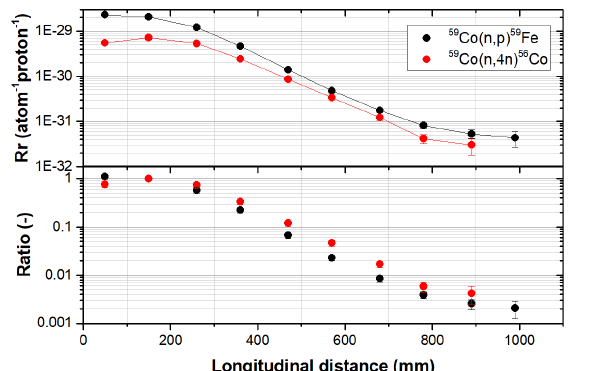
Figure 6. Determination and comparison of 59 Co ( n , p ) 59 Fe , and 59 Co ( n , 4 n ) 56 Co reaction rates at lead experiment.